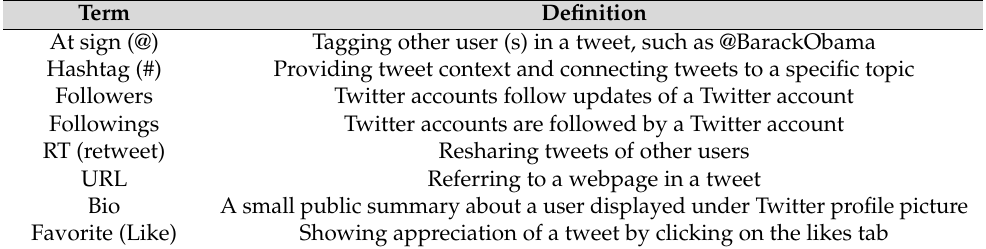
Table 1. Twitter